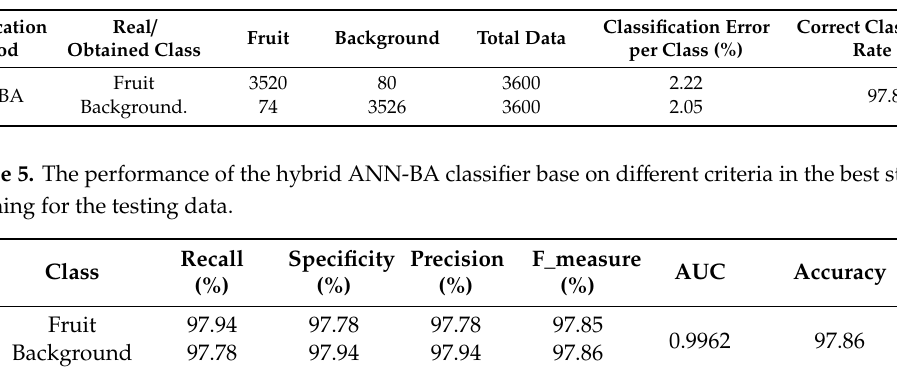
Table 4. Confusion matrices, classification error per class, and correct classification rate (CCR) in the best state of training of the hybrid ANN-BA classifier for the testing data.